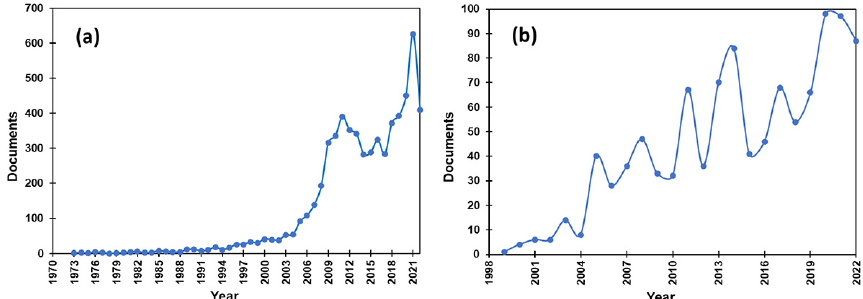
Fig. 1. Results of documents in SCOPUS by year of the search